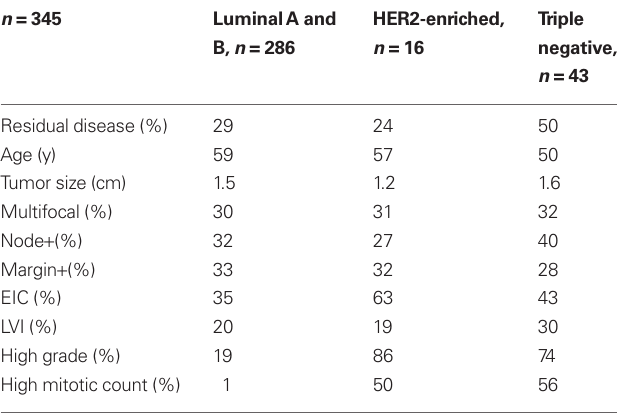
Table 3 | Descriptive statistics by molecular phenotype in the retrospective pathologic chart review examining rate of residual disease after lumpectomy.